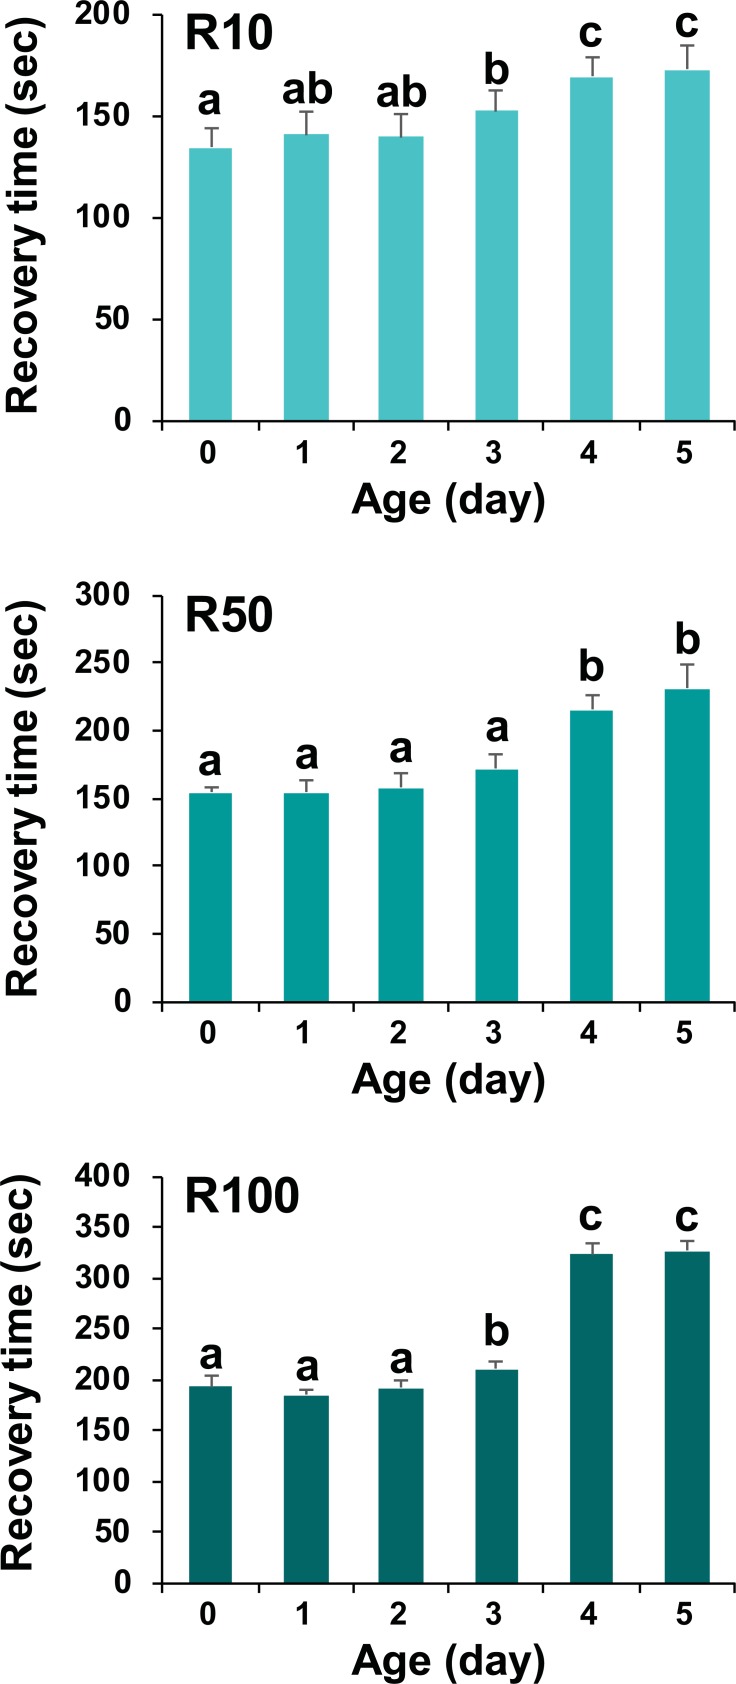
Effects of prolarval ages on recovery time after the anesthetic treatment with 200 mg/L of MS-222.Elapsed times to 10% (R10), 50% (R50) and 100% (R100) of fish (N = 20 per replicate; three replicates per age group) recovered were estimated with different age groups (Day 0 to Day 5). Mean ± SD with different letters (a-c) indicate the statistical difference at P < 0.05 based ANOVA followed by Tukey’s post hoc analysis. In contrast to recovery times, times to induction of anesthesia were not significantly influenced by ages of prolarvae (S5 Fig). Size of prolarvae and data on post-recovery viability are provided in S2 and S3 Tables, respectively. Age-dependent pattern of recovery time was also observable in prolarvae anesthetized with lidocaine (S6 Fig).